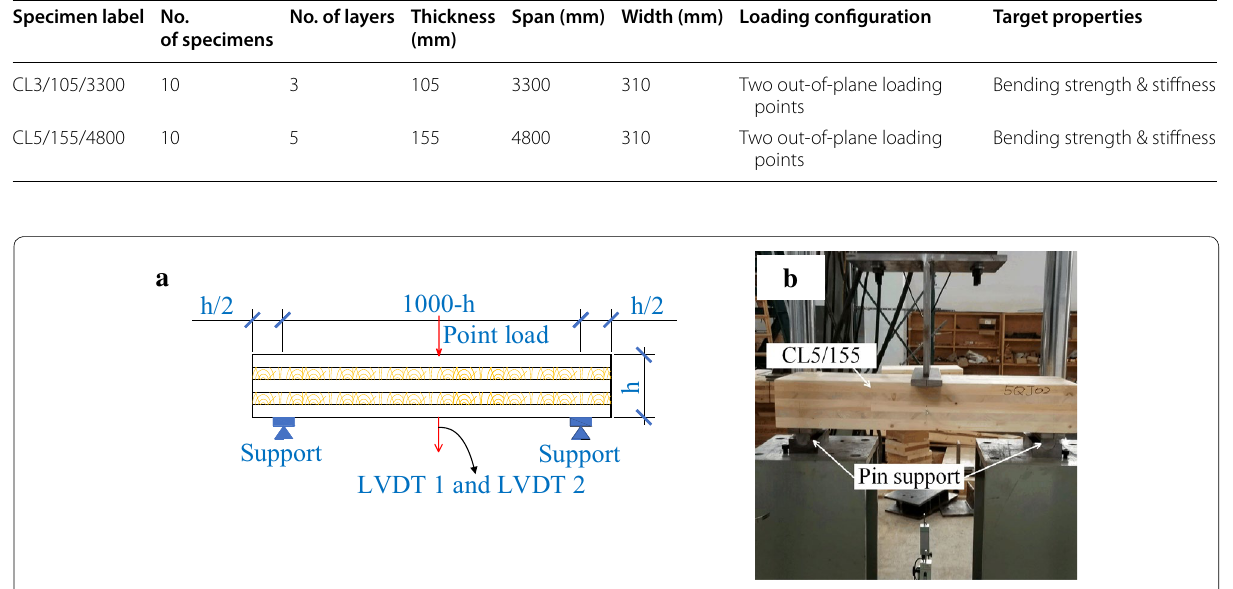
Fig. 4 The CLT shear specimen (5-layer CLT): a loading configurations; b shear test setup